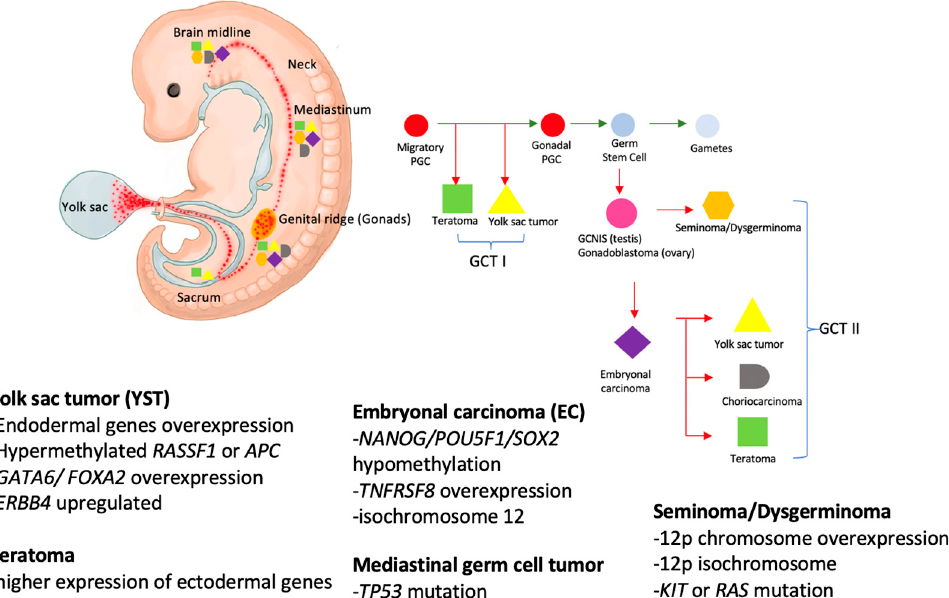
Figure 1. Primordial germ cell migration illustration and associated pathogenic gene mutations. Abbreviation: PGC: primordial germ cell; GCNIS: germ cell neoplasm in situ.